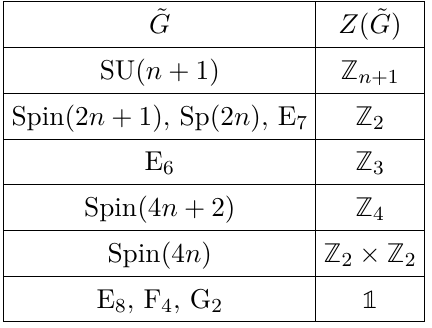
Table 5 . Center Z ( ˜ G ) of compact connected simple groups ˜ G